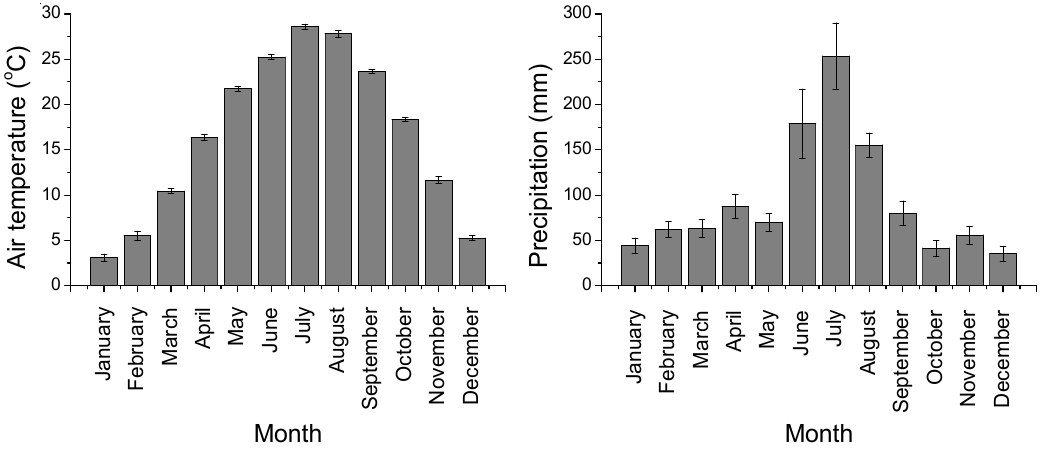
Figure 1. The annual mean air temperature and precipitation of Nanjing from 2000–2015. The experimental plots were located in Q. acutissima deciduous forest and C. lanceolata